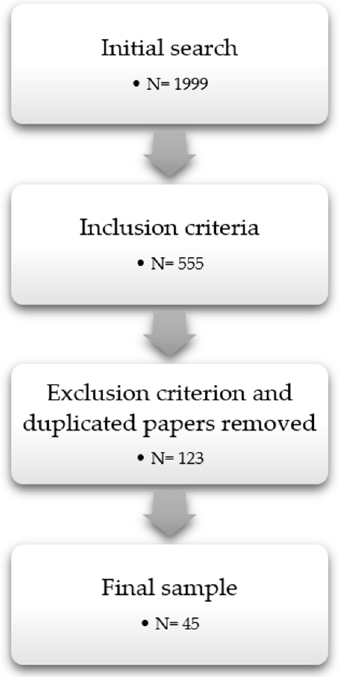
Figure 1. Search protocol.